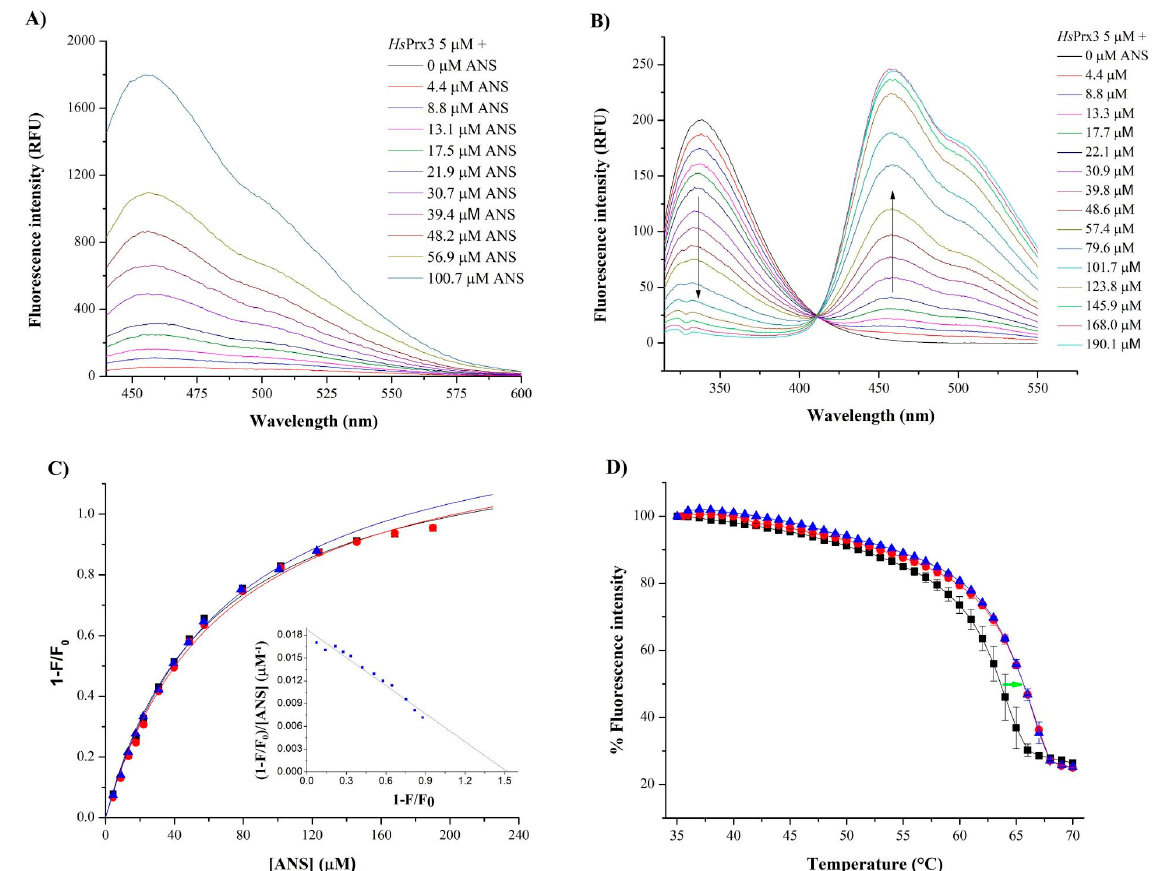
Figure 6. Binding of ANS and AA to Hs Prx3. ( A ) Direct fluorescence measurement of ANS at an excitation wavelength of 375 nm. For each ANS concentration, the spectrum shown corresponds to the difference between the recorded spectra in the presence and in the absence of Hs Prx3 (5 µ M). ( B ) Hs Prx3 (5 µ M) was incubated with increasing ANS concentrations and fluorescence emission spectra ( λ ex = 295 nm) were registered. The arrows indicate the direction of fluorescence changes observed after addition of different concentrations of ANS. ( C ) For three different protein concentrations (2 ( (cid:78) ), 5 ( • ) and 8 ( (cid:4) ) µ M), relative intrinsic fluorescence changes were plotted against [ANS], resulting in saturation curves which were fitted to hyperbolic functions. An example of the linearization through Scatchard plot corresponding to 2 µ M Hs Prx3 is shown in the inset. ( D ) Heat unfolding transitions following the intrinsic fluorescence intensity ( λ ex = 295 nm, λ em = 335 nm) of the tryptophans of Hs Prx3 (4 µ M) in the absence ( (cid:4) ) and presence of AA (10 µ M ( • ) and 20 µ M ( (cid:78) )) and DTT (2 mM). Green arrow shows the shift in the apparent Tm in the presence of